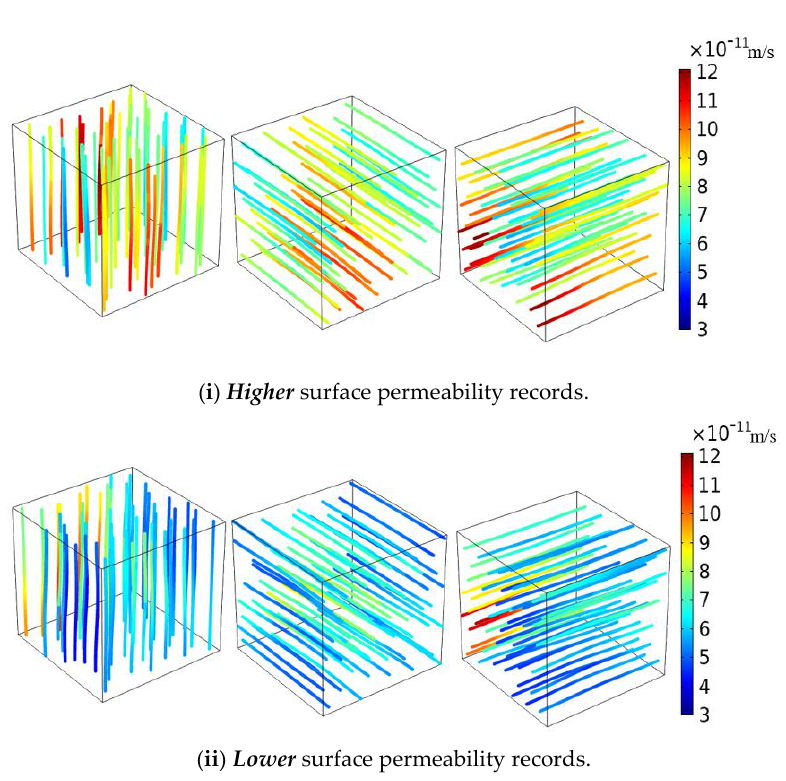
Figure 20. Computational results of flow patterns in three orthogonal directions obtained for the cuboid of Stanstead granite.